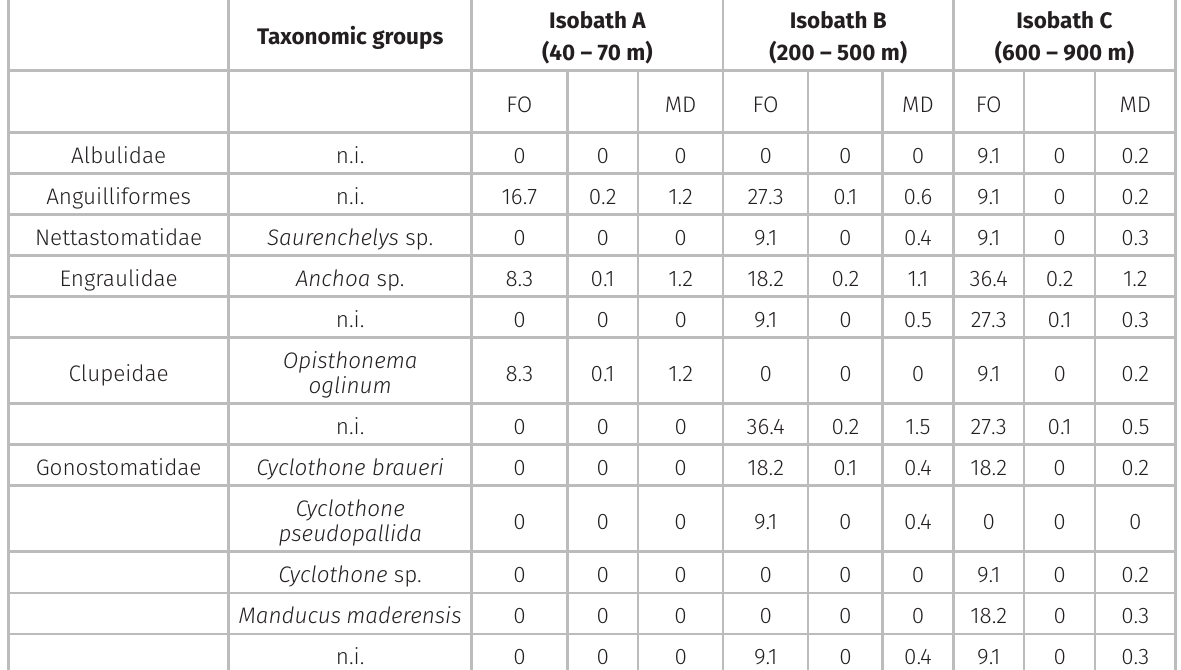
Table I. List of taxonomic groups, frequency of occurrence (%) and mean density in the isobaths A (outer continental shelf), B (upper continental slope) and C (deep continental slope). FO – frequency of occurrence;